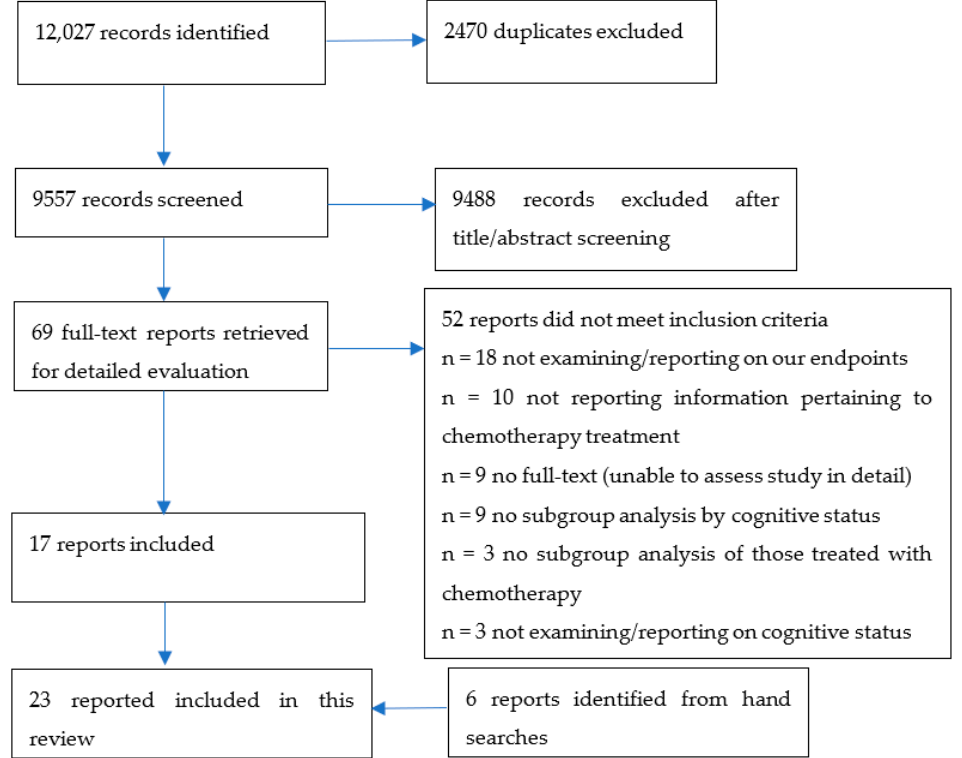
Figure 1. PRISMA flow diagram.